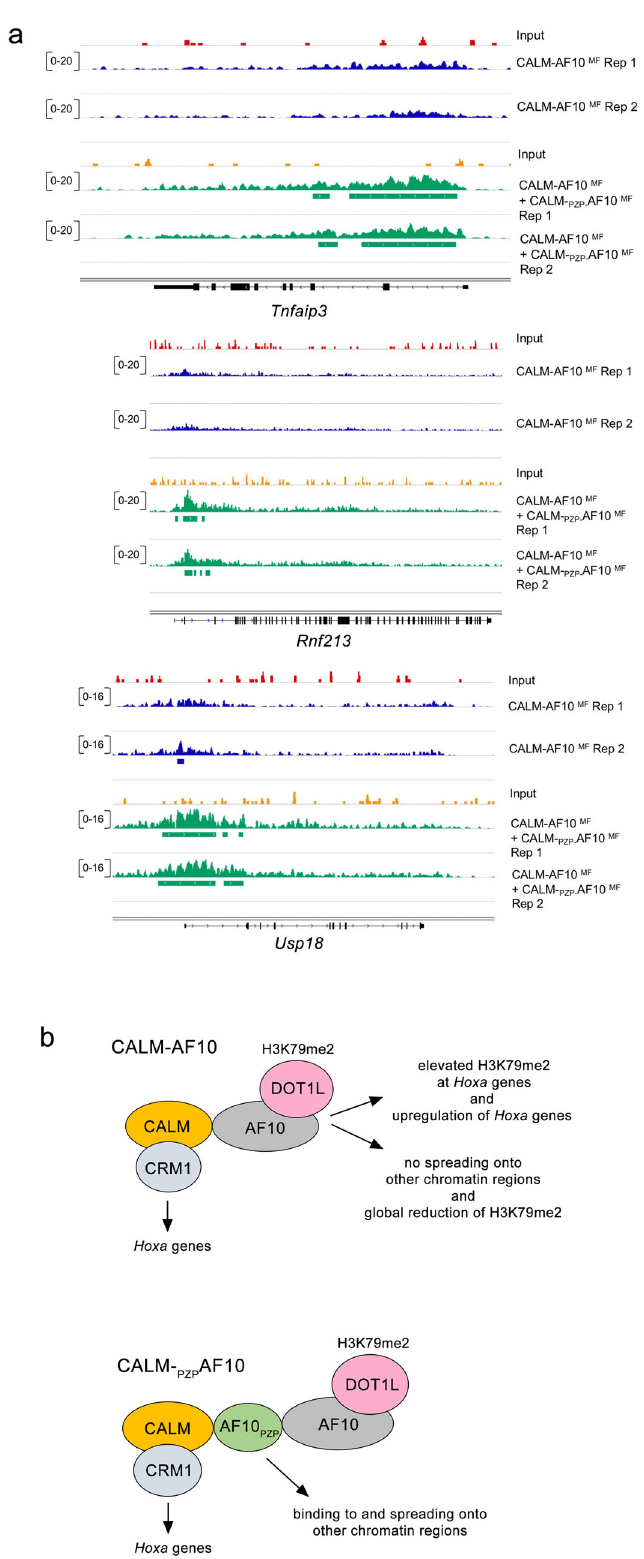
Fig. 10 The role of AF10 PZP in CALM-AF10-mediated leukemogenesis. a Representative pro fi les of H3K79me2 peaks in CALM-AF10 MF leukemias without (upper panels, blue tracks) or with co-transduction of the CALM- PZP AF10 MF fusion (lower panels, green tracks). Red tracks and orange tracks represent ChIP input control for CALM-AF10 MF and CALM-AF10 MF + CALM- PZP AF10 MF samples, respectively. Data from 2 independent ChIP replicates is shown. b Schematic of the mechanism of AF10 PZP -dependent CALM-AF10-mediated leukemogenesis.